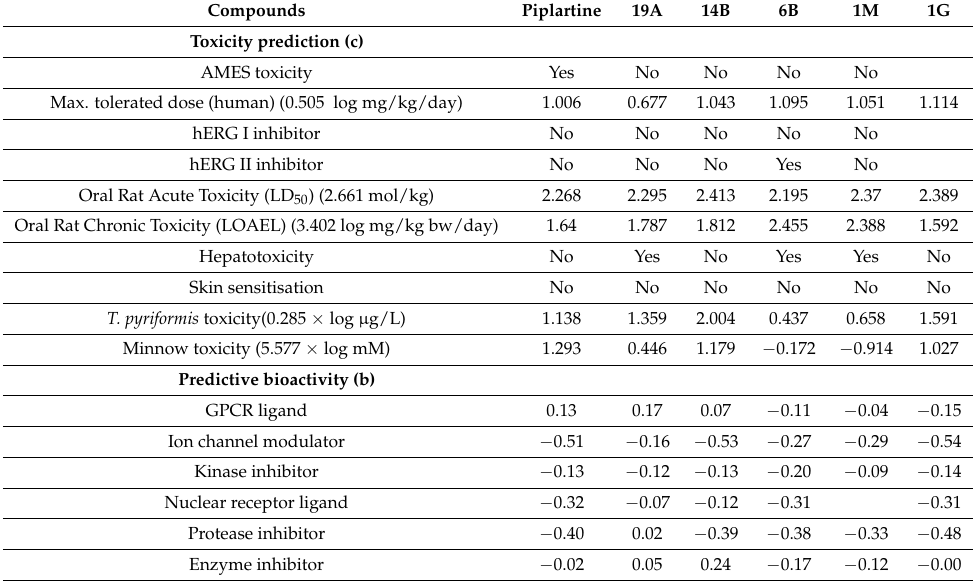
Table 2. Toxicity analysis and bioactivity prediction of the parent and analogue compounds against various drug targets.